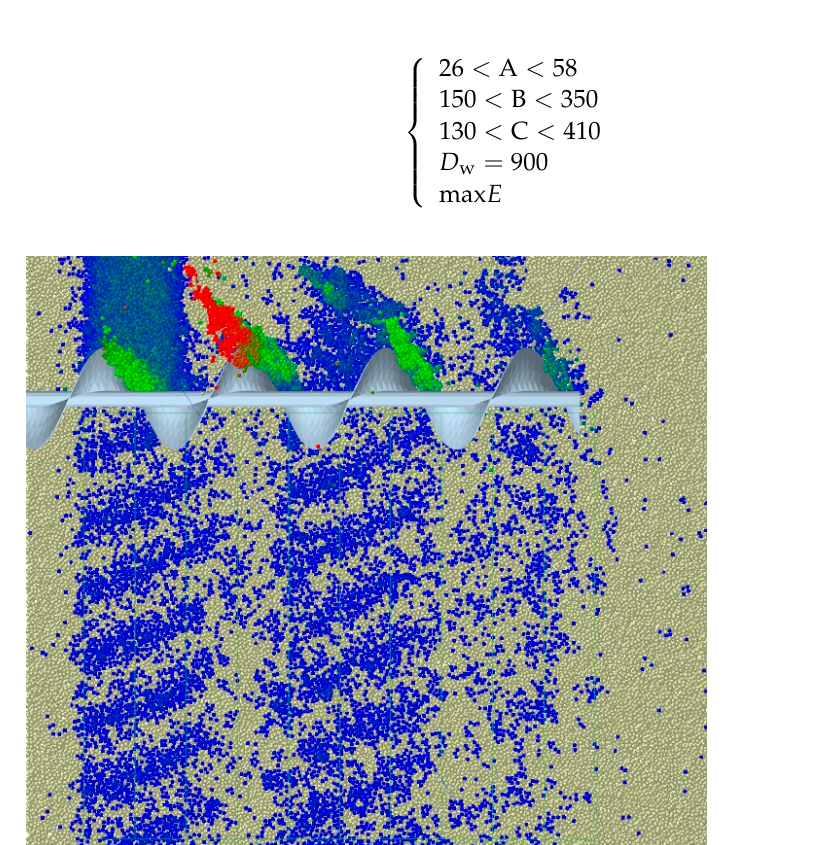
Figure 15. Simulation results after optimizing parameters of spiral soil separating device.